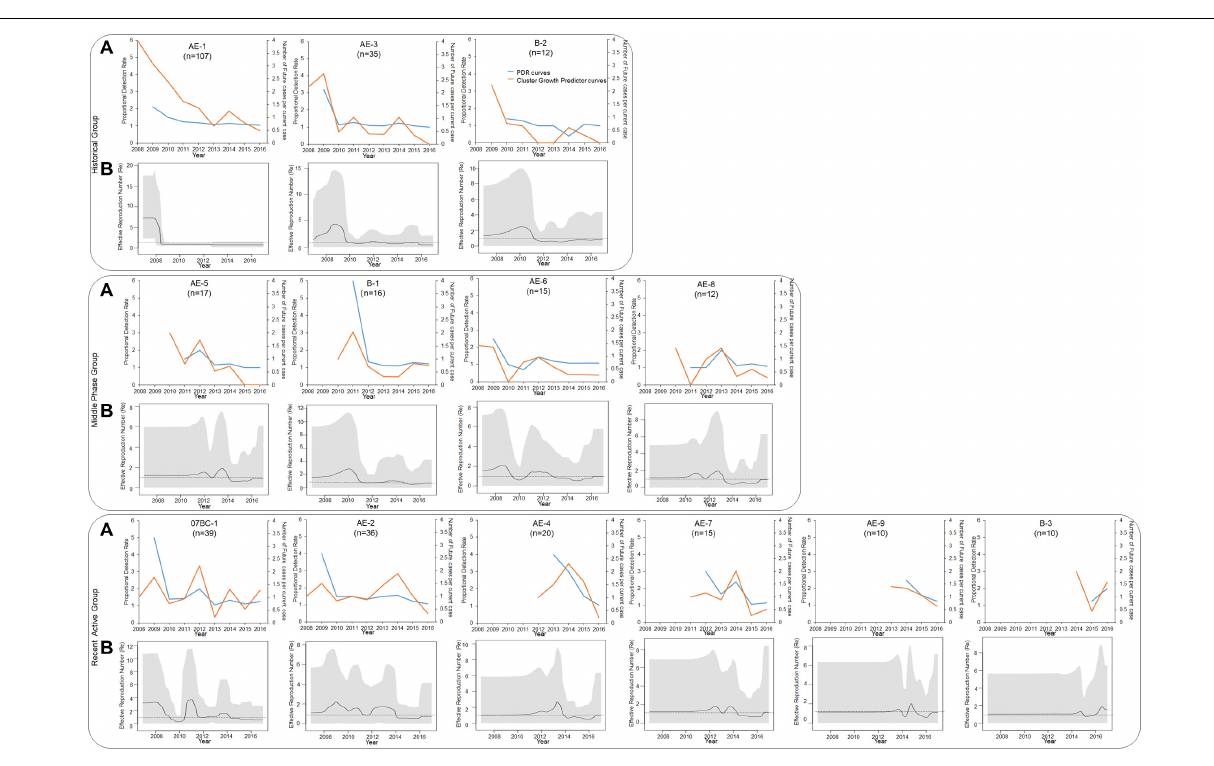
B-3 were recently emerged clusters that appeared in 2013 and 2014, respectively. The PDR of 5 of the 6 recently active clusters decreased or remained at a constant low level; the exception was